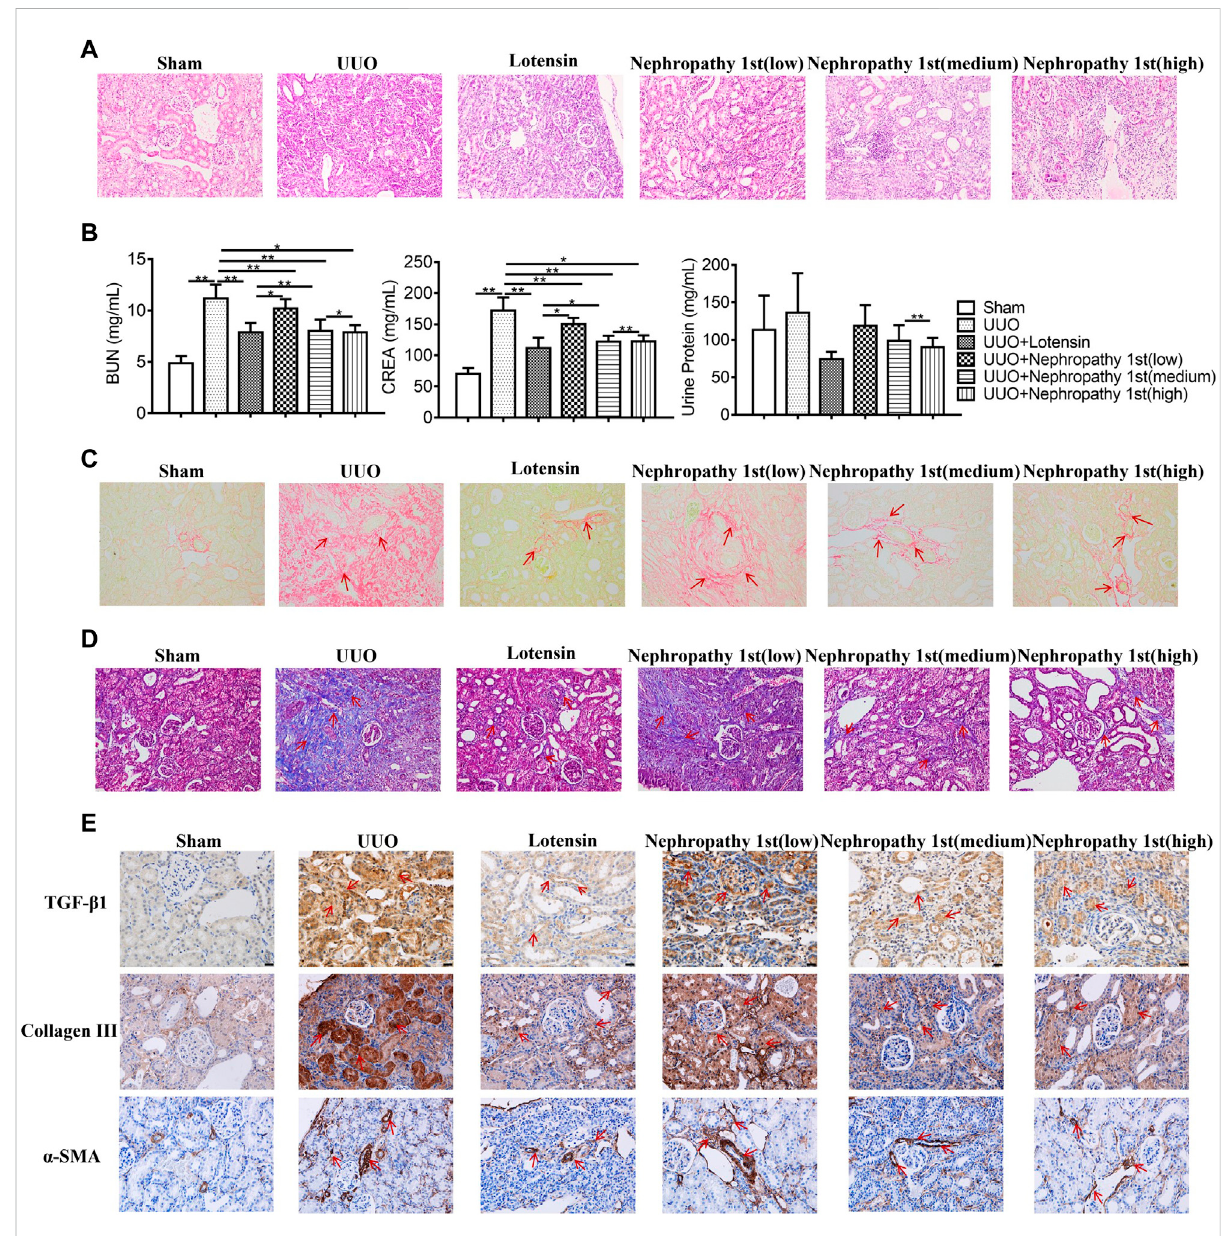
Nephropathy 1st inhibited TGF- β 1-induced myo fi broblast formation. (A) HE staining of rat kidneys. (B) Serum creatinine (CREN), urea nitrogen (BUN),andurineproteinconcentrationsweremeasuredinthebloodofrats. (C) SiriusRedstainingand (D) Massonstainingofdifferentkidneytissues. (E) IHC staining of TGF- β 1, collagen III, and α -SMA in rat kidneys. Data were representative of three independent experiments. Data were shown as mean ± SD, * p < 0.05 and ** p <